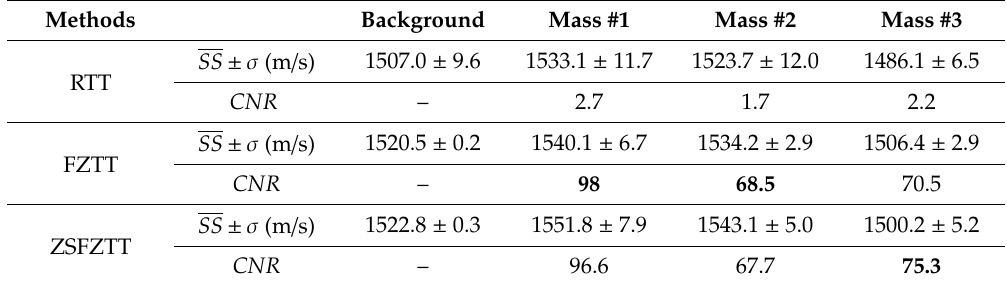
Table 5. The CNR measured on SS image of numerical phantom reconstructed by RTT, FZTT, and ZSFZTT